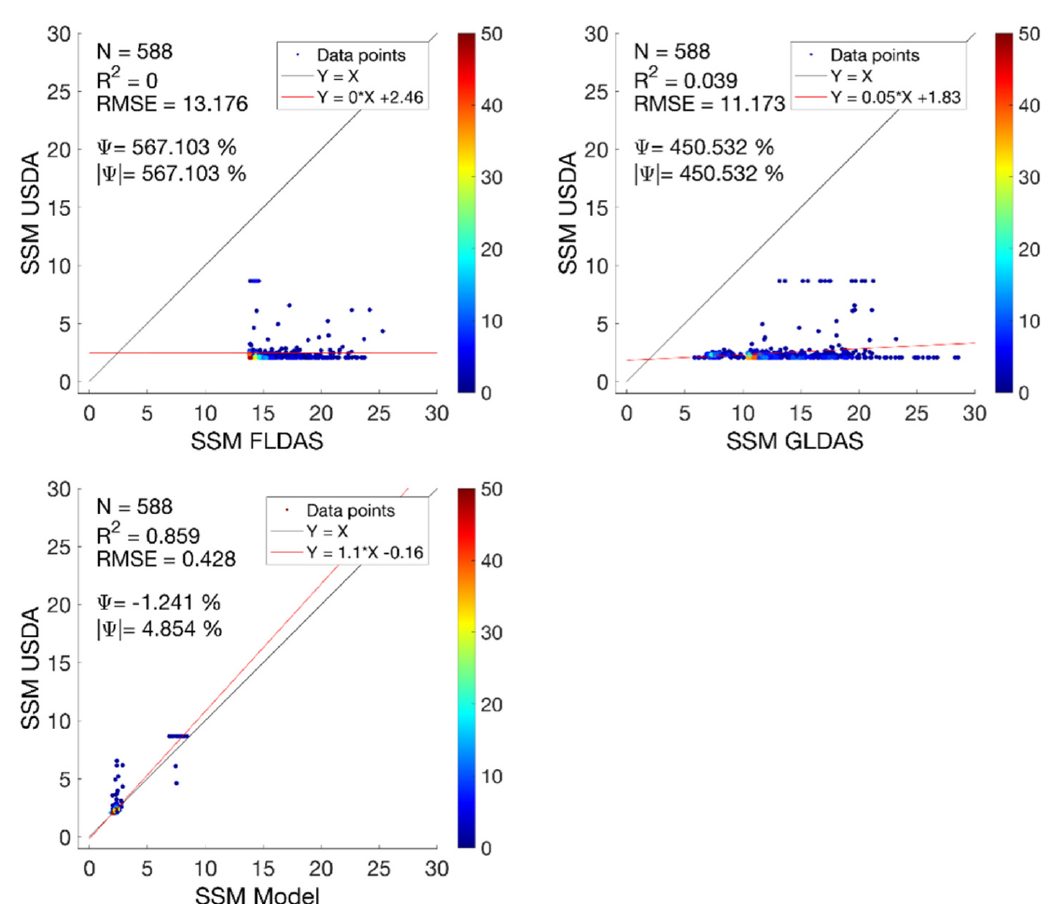
Figure 12. Comparisons of NASA-USDA SSM versus SSM values obtained from FLDAS, GLDAS and the proposed model using testing data in Egypt. The solid black and red lines represent the one to one line and regression line, respectively.